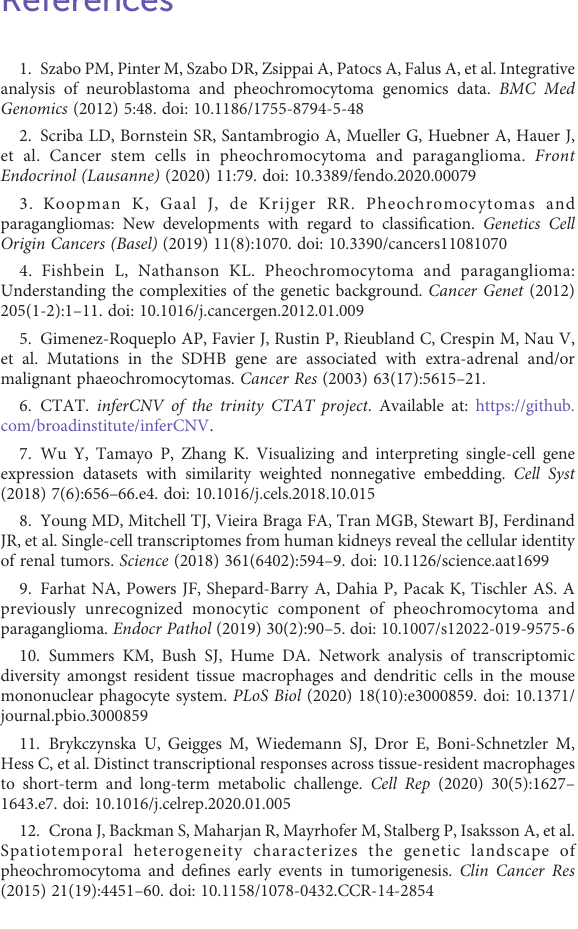
SUPPLEMENTARY FIGURE 1 (A) Per-sample QC metrices after fi ltering (UMI count: nCount_RNA, Gene count: nFeature_RNA, blue: ‘ SDHB group ’ , red: ‘ RET-group ’ ). (B) UMAP visualization of the merged dataset separately annotated by patient SUPPLEMENTARY FIGURE 2 (A) UMAP visualization of the PCPG immune cells subcluster after re- clustering (no batch-correction). The arrows point at the cells annotated